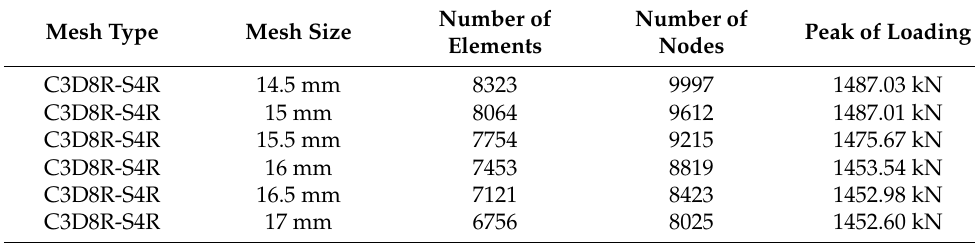
Figure 3. The main failure modes of CCFST and SCFST columns in this study. Table 4. Parameters for mesh